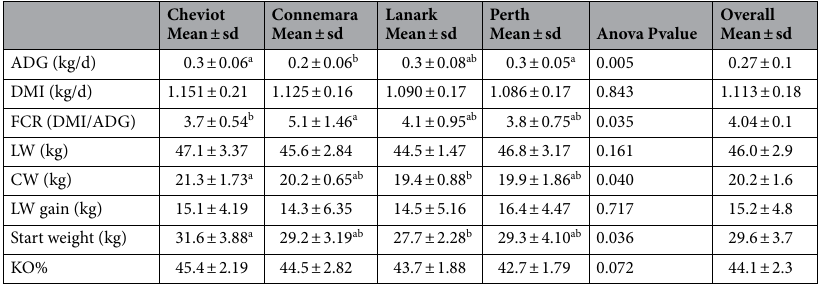
Table 1. Animal production traits for Cheviot, Connemara, Lanark, and Perth. Mean ± Sd, ANOVA P value and Tukey HSD pairwise comparisons (superscripts) presented in table. ADG (Average Daily Gain), DMI